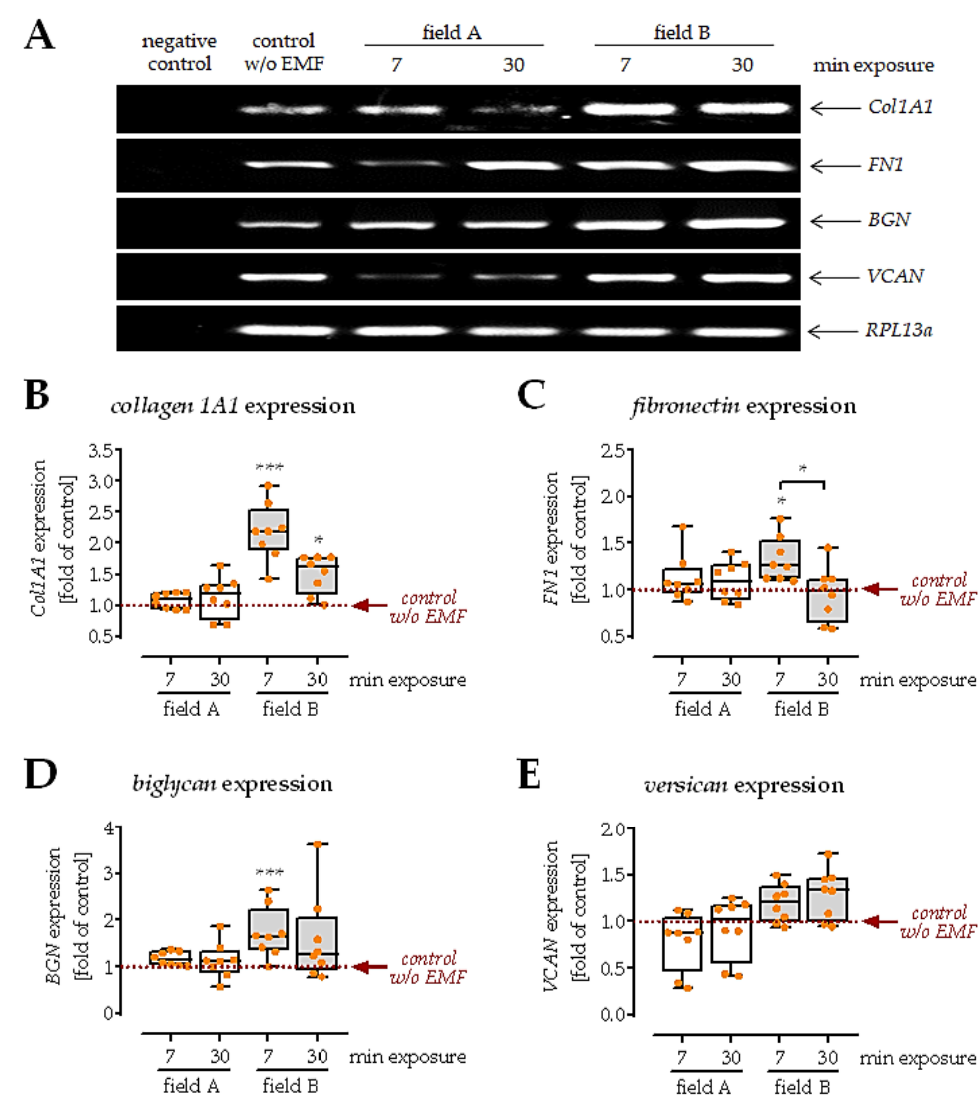
Figure 6. Gene expression of matrix proteins in SCP-1 cells cultured with conditioned medium from macrophages exposed to the ELF-PEMFs for 1 week. Freshly isolated PBMCs ( n = 5) were stimulated with 200 nM PMA and exposed to the two ELF-PEMF for 7 min or 30 min, respectively. After 24 h, the conditioned medium was collected and added (1:1) to differentiate SCP-1 cells. ( A ) Representative images of the RT-PCR. All uncropped agarose gel images are shown in Supplementary Figure S2. ImageJ software was used to quantify signal intensities of ( B ) collagen 1A1 ( Col1A1 ); ( C ) fibronectin ( FN1 ); ( D ) biglycan ( BGN ); and ( E ) versican ( VCAN ). RPL13a was used as a housekeeping gene for normalization. Data were compared by non-parametric Kruskal–Wallis test, followed by Dunn’s multiple comparison test: * p < 0.05 and *** p < 0.001 as compared to control conditions (without ELF-PEMF